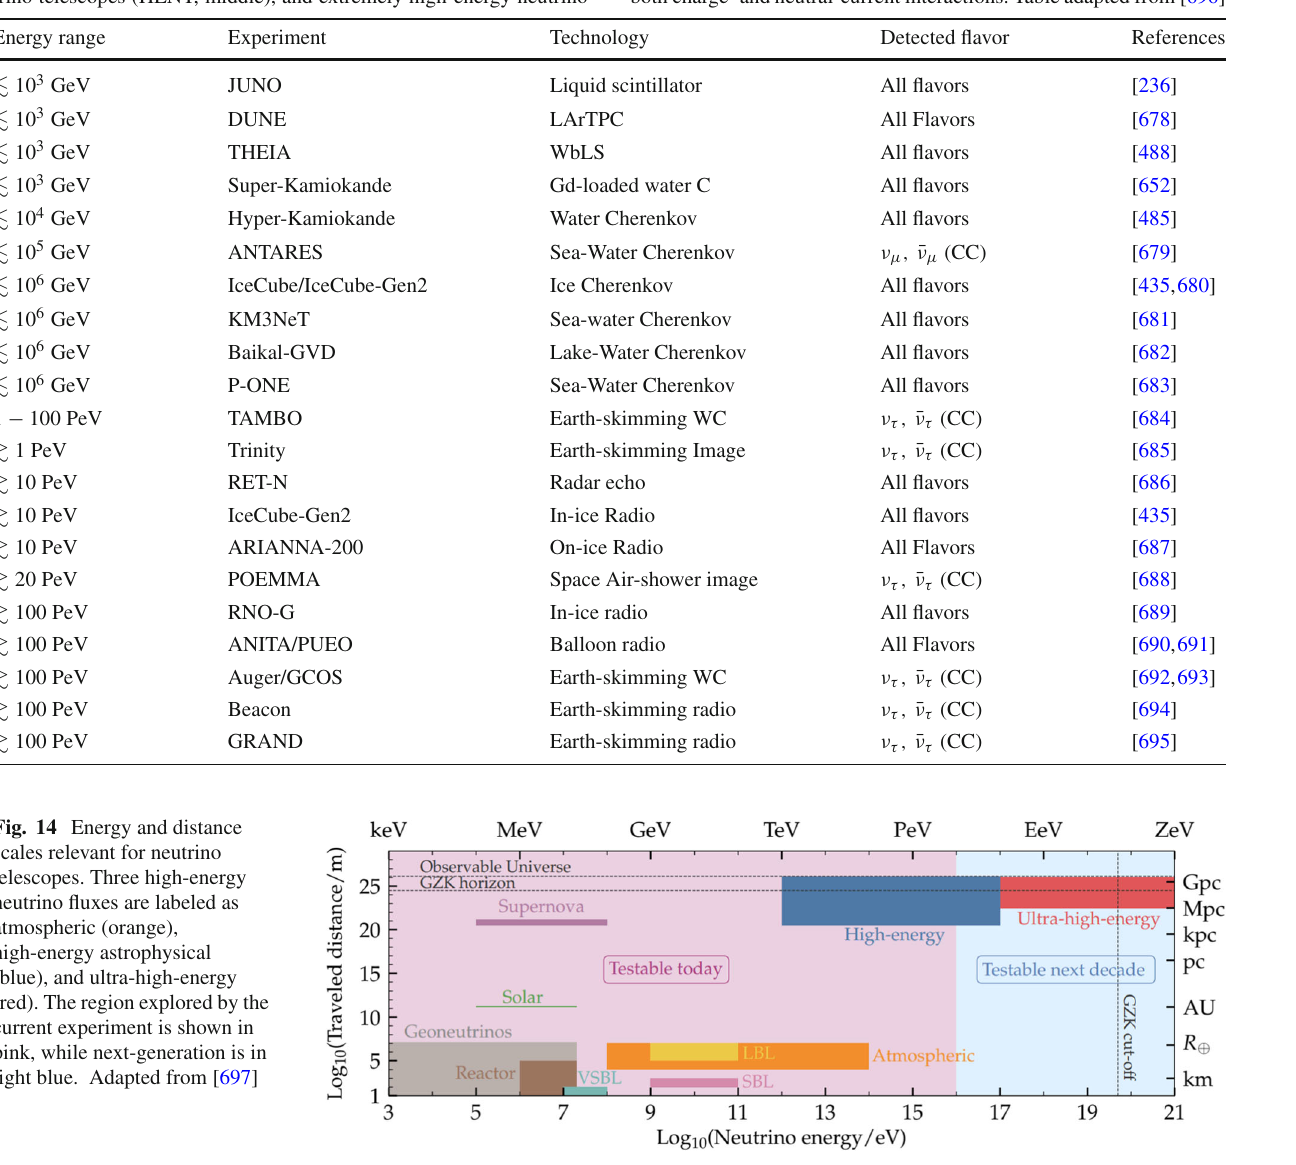
Table5 Neutrinodetectorsandneutrinotelescopessortedfromsmaller to larger energies. These are grouped into three categories separated by the double lines: large neutrino detectors (top), high-energy neu- trino telescopes (HENT, middle), and extremely high-energy neutrino